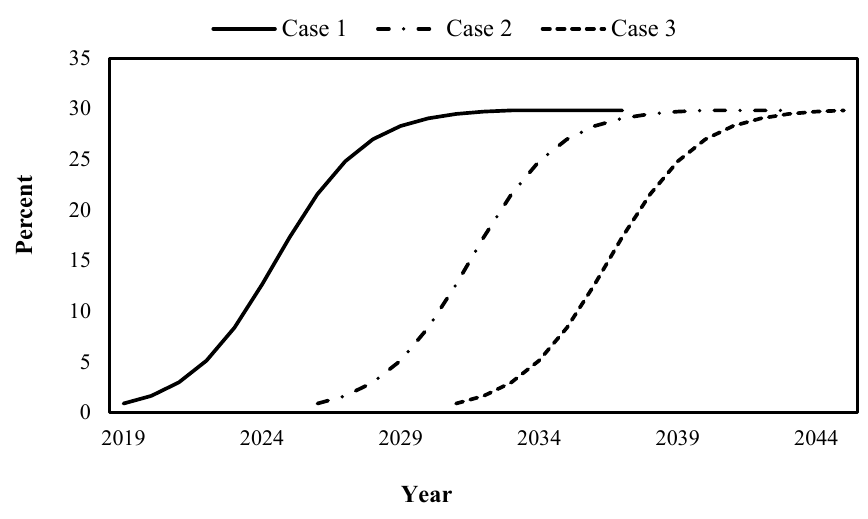
Fig. 7 Potential economic benefits from different adoption scenarios of ‘BARI Gom 33’. Source: authors’